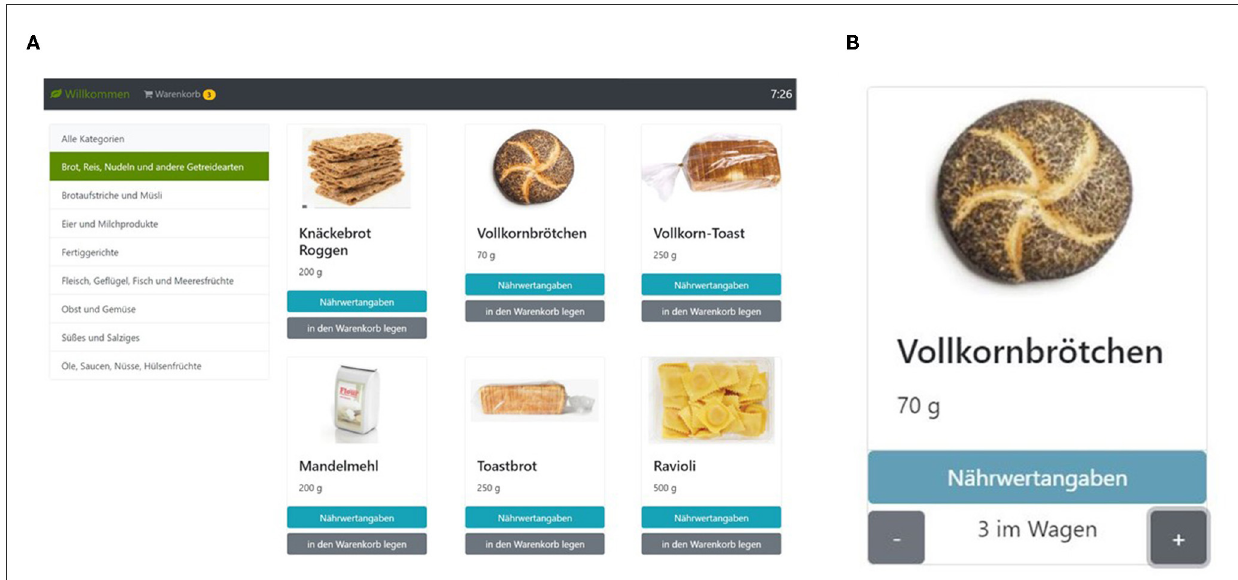
FIGURE1 The screenshot of the supermarket task. (A) Participants could choose different food categories shown on the left side to see the items belonging to the respective category (in the example, the category ‘bread, rice, pasta, and other grain products’ has been selected). On the top right corner, the remaining shopping time is shown; on the top left, they can see their shopping basket (“Warenkorb”), which can be selected to modify its contents and place the order. (B) For each object, participants can choose to inspect the nutritional values (“Nährwertangaben”) and select how many exemplars of the item they wish to put in their basket. The shopping task is publicly available for non-commercial use; please see Supplementary material for further